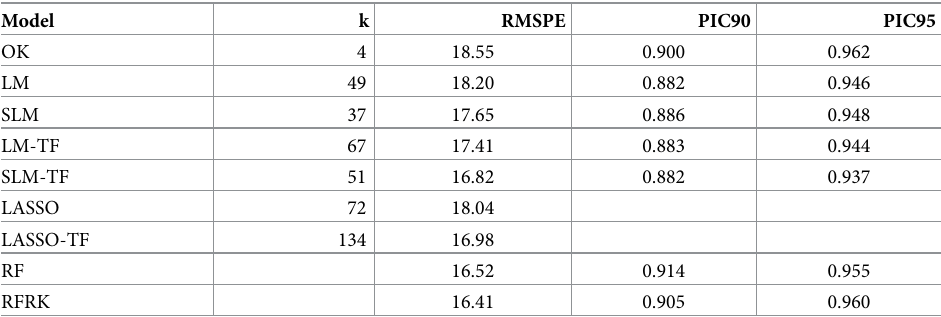
Table 1. Cross-validation performance